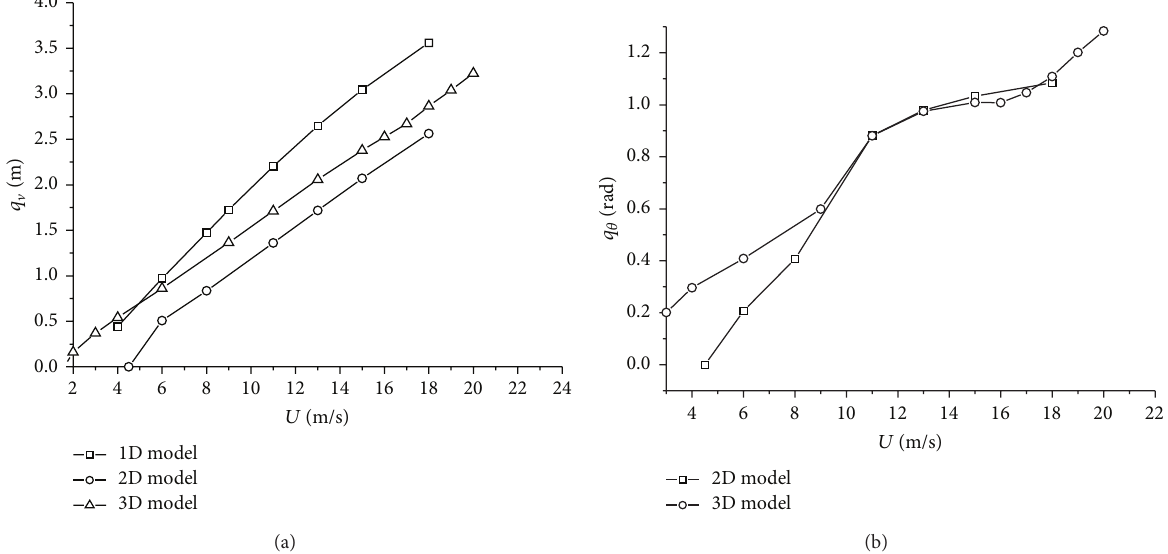
Figure 4: The influence of the velocity on the galloping amplitude: (a) vertical amplitude and (b) torsional amplitude.